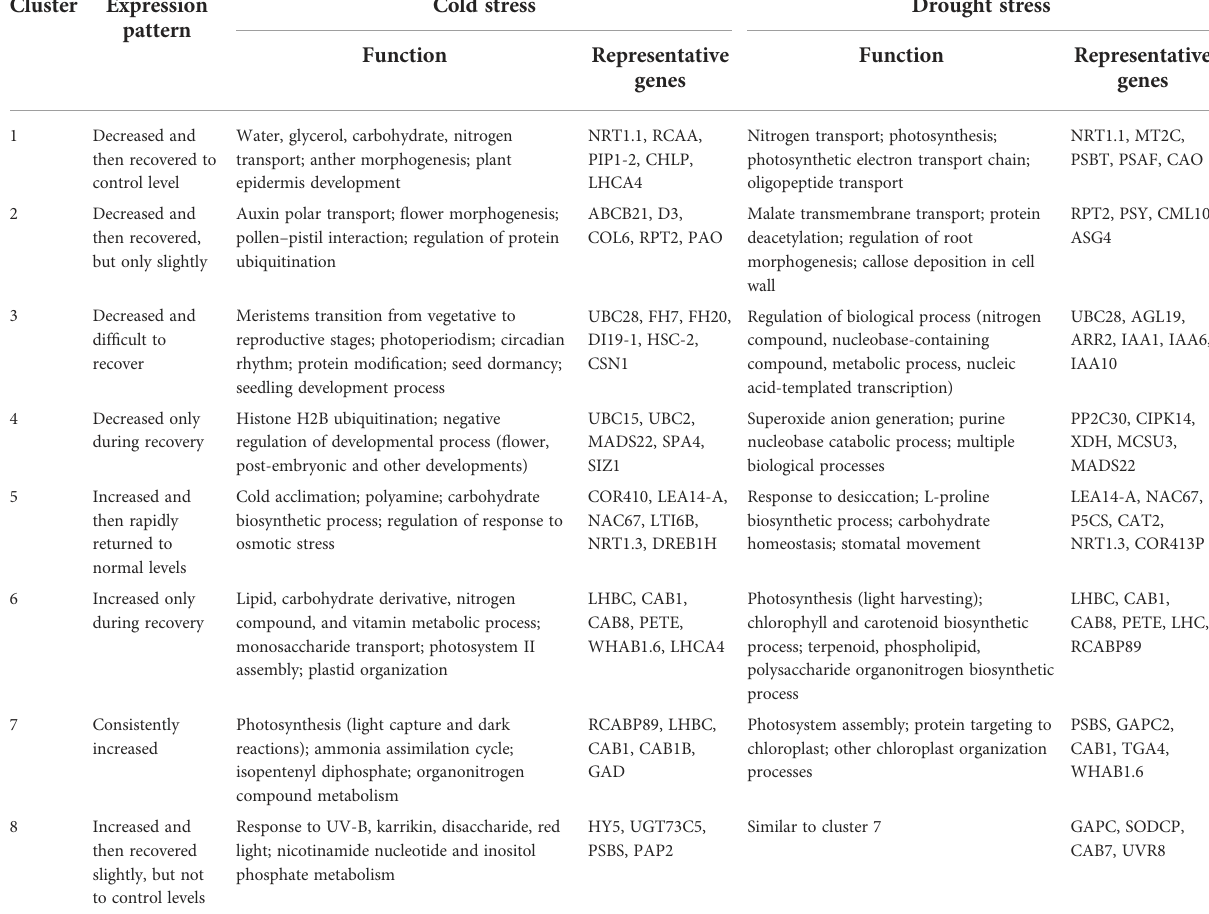
TABLE 1 The gene functions of different patterns in response to cold or